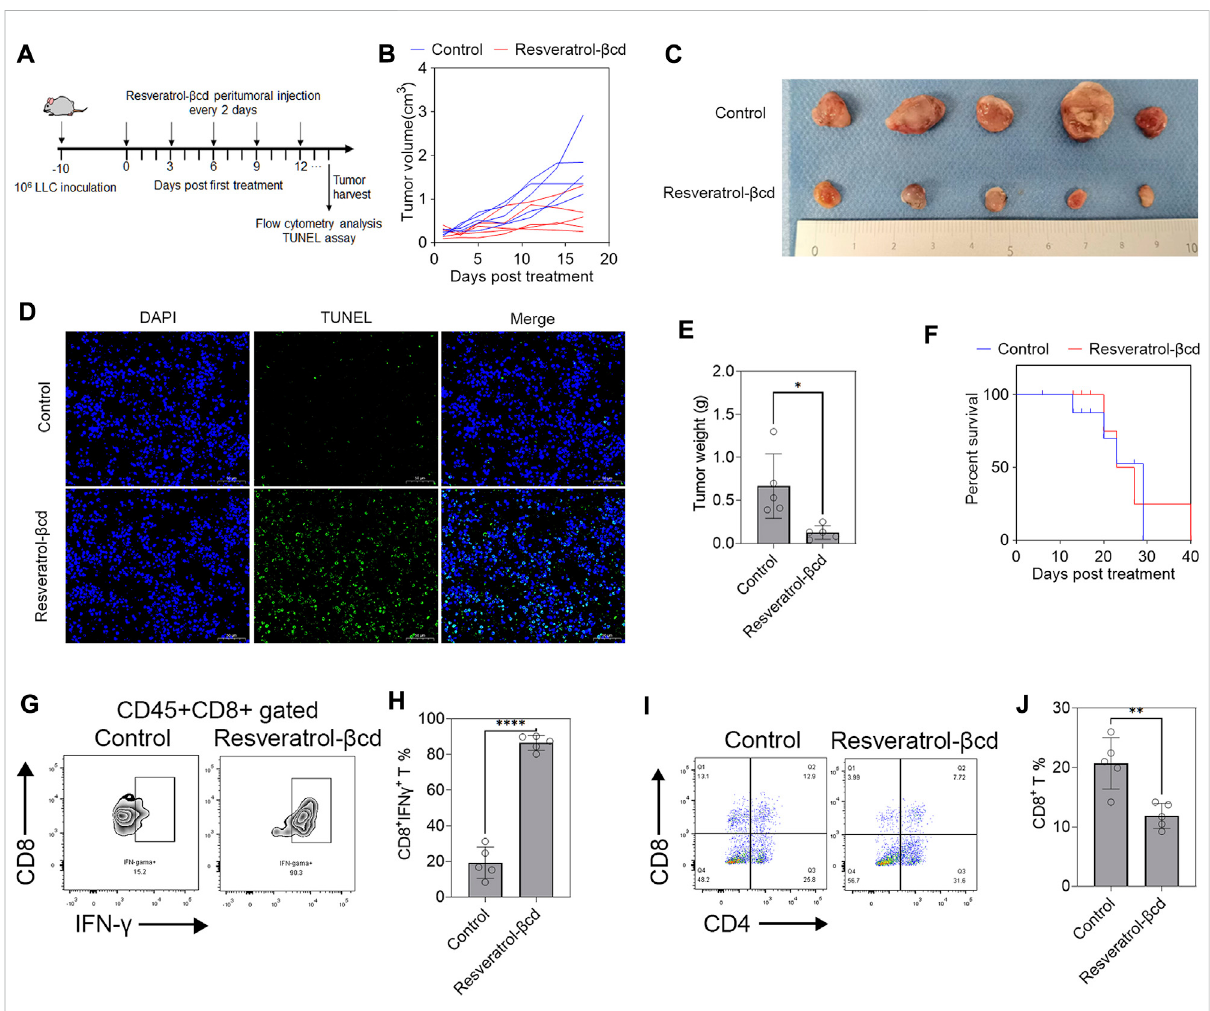
FIGURE 2 Resveratrol- β cd activates tumor-in fi ltrating CD8T cells against lung adenocarcinoma. (A) A graphical representation showing the timeline of in vivo experiments. A total of 10 6 LLC cells were inoculated into the right fl ank of mice. Approximately 10 days post-inoculation, the tumor volume reached around 300 mm 3 and drug administration began. The fi rst day of drug administration was recorded as Day 0 post-treatment. Paratumoral injections were administered every 2 days until reaching the humane endpoint. (B) Resveratrol- β cd, equivalent to 5 mg/kg resveratrol, was injected adjacent to the tumor every 2 days, while the control group received the same amount of β cd. The results showed signi fi cant inhibition of tumorgrowthinthetreatmentgroup( n =5). (C) Typicalimagesoftumorsafterthemiceweresacri fi ced17 daysaftertreatment. (D) Atypicalgraphof TUNELanalysisoftumorapoptosis17 daysaftertreatment.Scalebar=50 μ m. (E) Themeantumormassesafterdissectionwere0.126 gand0.666 g in the treatment and control groups, respectively. Error bar = mean ± S.D., n = 5; * p = 0.014. (F) Survival curves of the resveratrol- β cd and control groups. All mice in the control group reached the humane endpoint at 29 days post-treatment, compared to 40 days in the resveratrol- β cd group. n = 5. (G) Typical fl ow cytometry diagram of CD8T activation in tumors. The cells were CD45 + CD8 + gated. (H) CD8T cell activation in